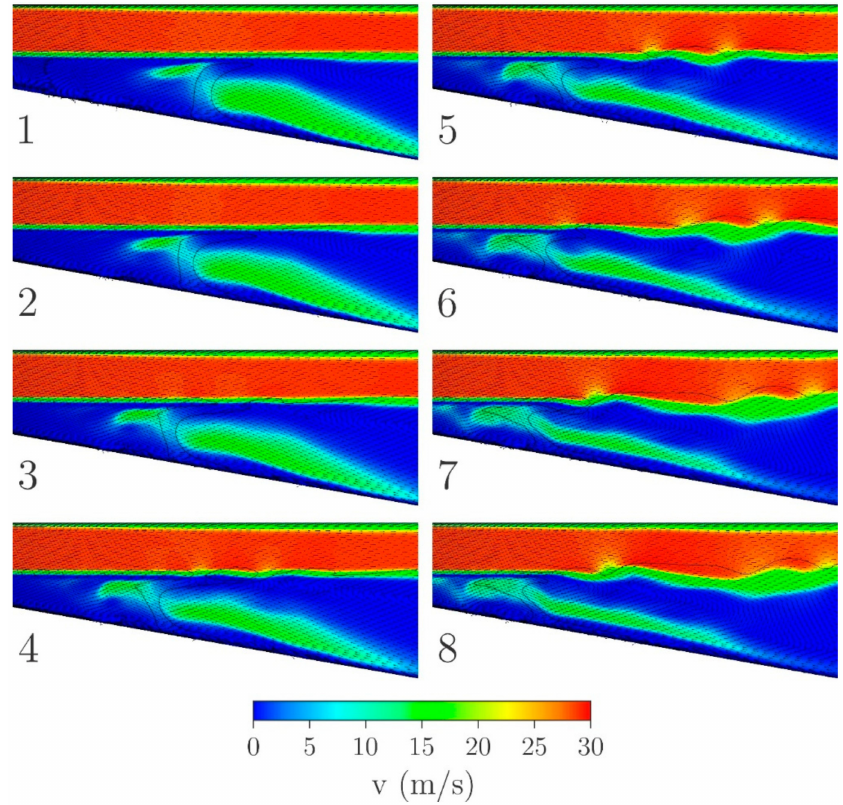
Figure 6. A close-up view of the initial development of Kelvin-Helmholtz instability. The time difference between the images is ∆ t = 20 µ s. The black line shows a 10% vapor fraction region